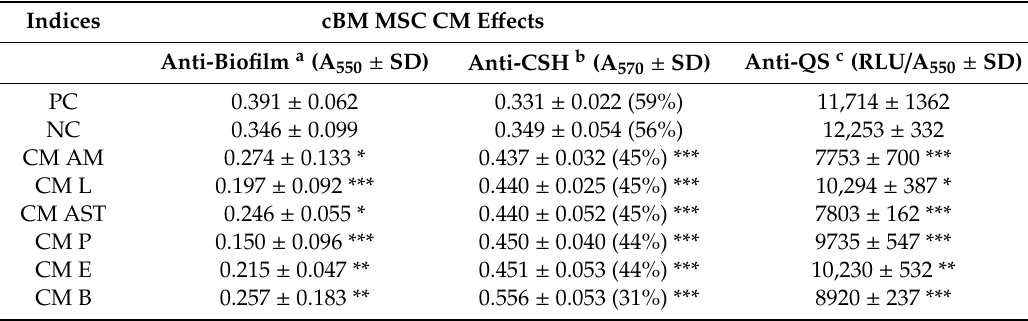
Table 2. Antibiofilm SCVA, anti-CSH and anti-QS activities of cBM MSC